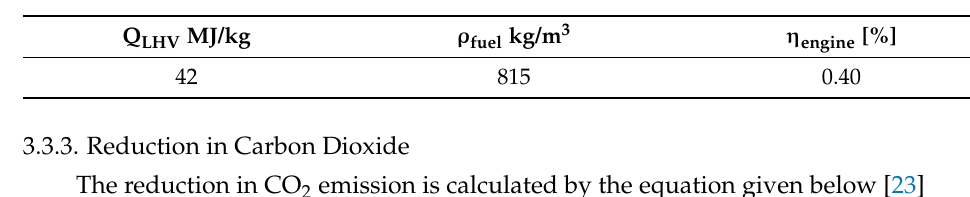
Table 2. Property of the diesel fuel and IC engine thermal efficiency [20–22].